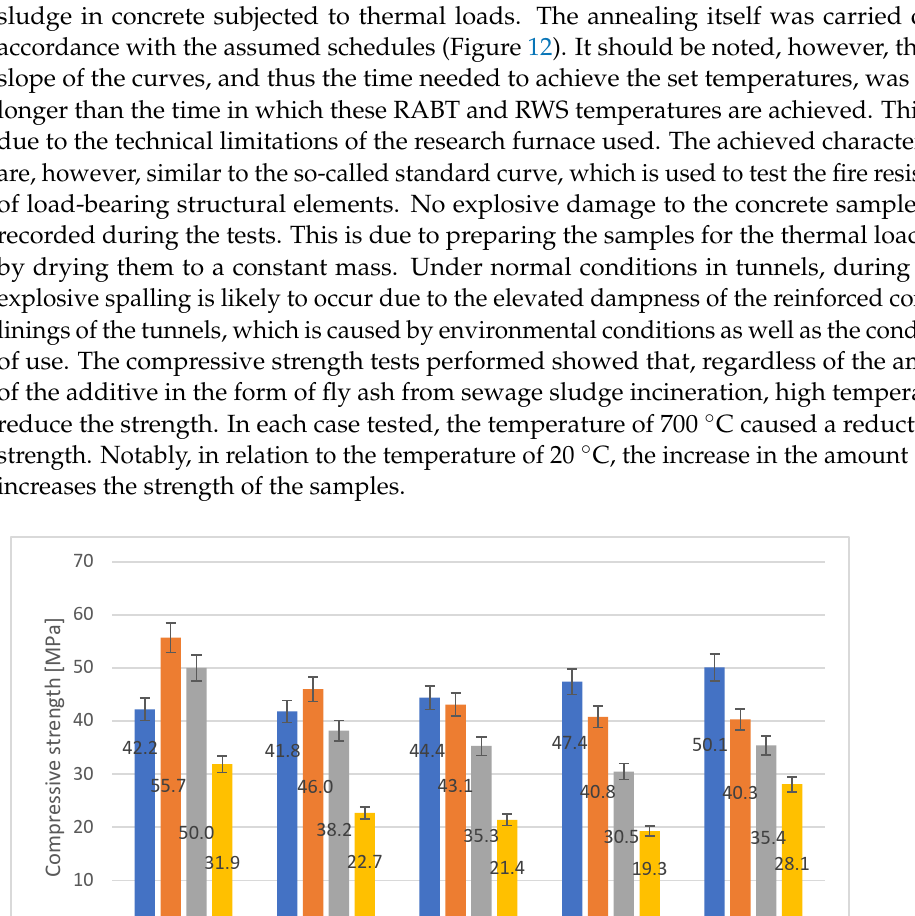
Figure 11. Temperature distribution in the pilot sample—300 °C Heating Curve.